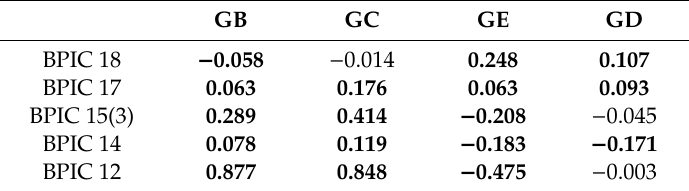
Table 2. Spearman Rank Correlation between group centrality measure and trace cycle